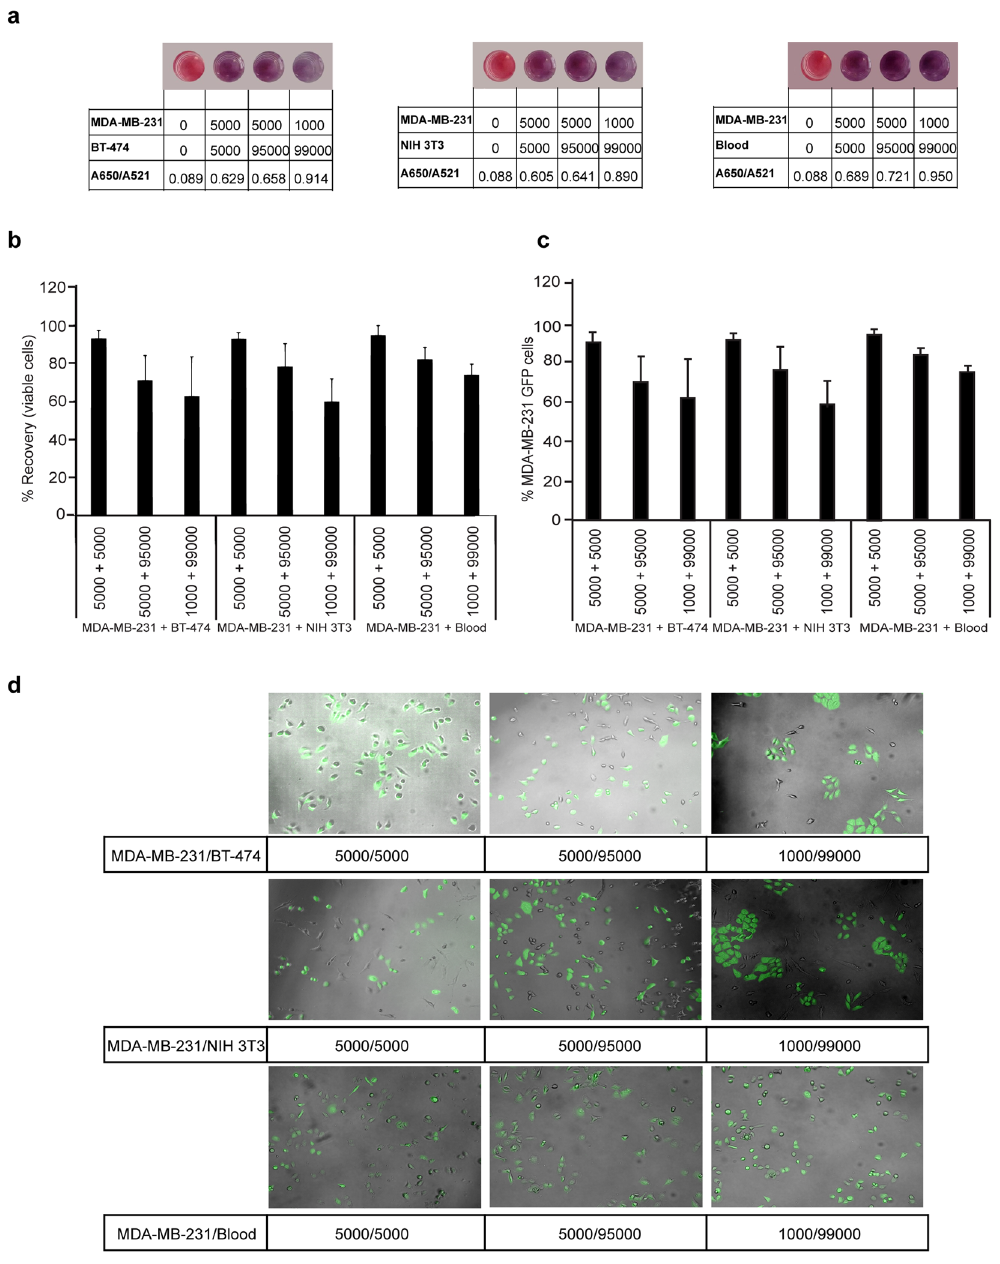
Figure 5. Au-PEG-HA NP-mediated recovery of viable cells of interest from a heterogeneous population. ( a ) Colorimetric changes (with A650/A521 ratio) of Au-PEG-HA NPs after interaction with a mixture of cells (MDA-MB-231 + BT-474, MDA-MB-231 + NIH 3T3, MDA-MB-231 + Blood cells) with different MDA-MB-231 cell densities (50%, 5%, 1% of MDA-MB-231 cells). ( b ) Recovery of viable MDA-MB-231 cells from a mixture of spiked MDA-MB-231 cells with BT-474/NIH 3T3/Blood cells at different cell densities (50%, 5%, 1% of MDA-MB-231 cells). The cell mixtures were treated with Au-PEG-HA NPs for 10 min, and then separated by differential centrifugation (600 rpm/30 min). The cells were disassociated from NPs by vortex and checked for viability by the trypan blue live/ dead cell counting assay. ( c ) Recovery of viable MDA-MB-231 cells from a mixture of spiked MDA-MB-231-GFP cells with BT-474/NIH 3T3/Blood cells at different cell densities (50%, 5%, 1% of MDA-MB-231 cells) followed by a 10 minute incubation with Au-PEG-HA NPs and separation by differential centrifugation (600 rpm/30 min). The isolated cells were evaluated by FACS analysis. ( d ) Representative merged brightfield and fluorescent microscopy images of MDA-MB-231-GFP cells cultured from recovered viable cells after 24 hr